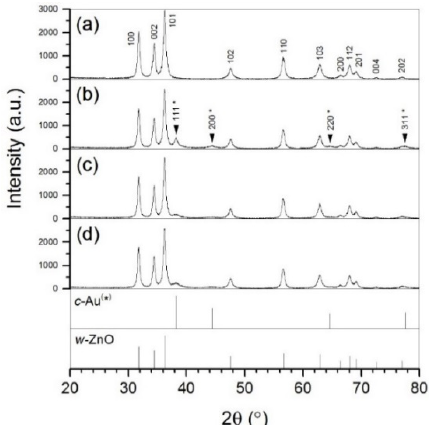
Figure 2. X-ray patterns of ( a ) the ZnO support and those Au-NPs/ZnO samples obtained using ( b ) Direct Turkevich; ( c ) Inverse Turkevich and ( d ) Progressive Heating as impregnation method. Below : JCPDS # 36-1451 ( w -ZnO) and JCPDS # 04-0784 ( c -Au) cards are shown for reference. Table 1. Intensity ratio of the strongest c -Au and w -ZnO X-ray reflections [( I 111 ) Au /( I 101 ) ZnO )], gold loading (Au wt.%), crystallite size ( τ ), mean particle size of Au-NPs ( D m -Au-NPs), wavelength at the maximum absorbance of the surface plasmon resonance band (SPR- λ max ), BET surface area ( S BET ), decolorization efficiency ( η ), and apparent rate constant ( k ) of the obtained catalysts. ZnO Au-NPs/ZnO Au-NPs/ZnO Au-NPs/ZnO Support Direct Turkevich Inverse Turkevich